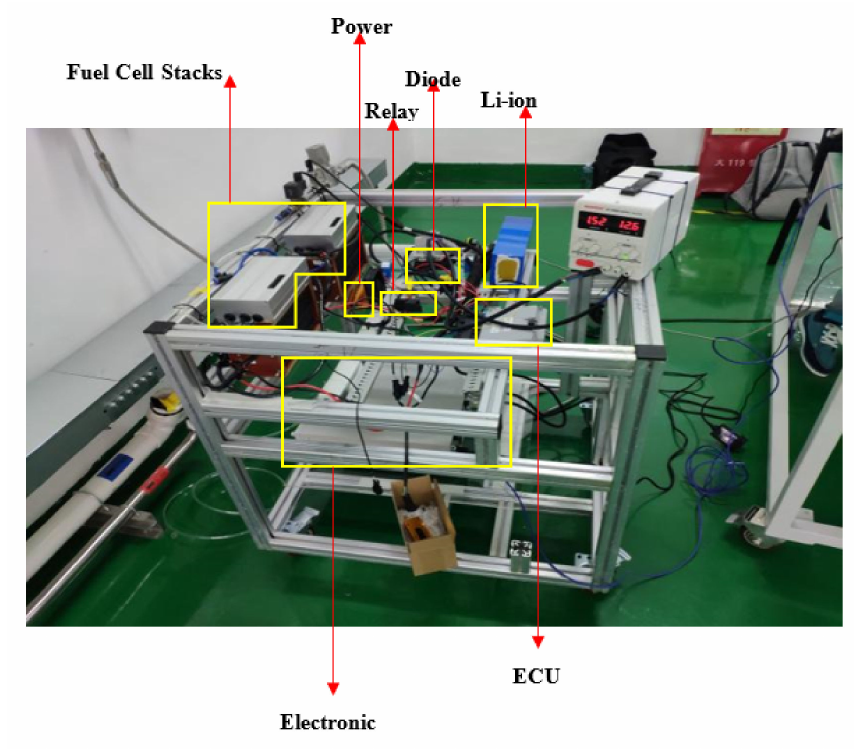
Figure 3. The passive fuel cell/battery hybrid power system on the test